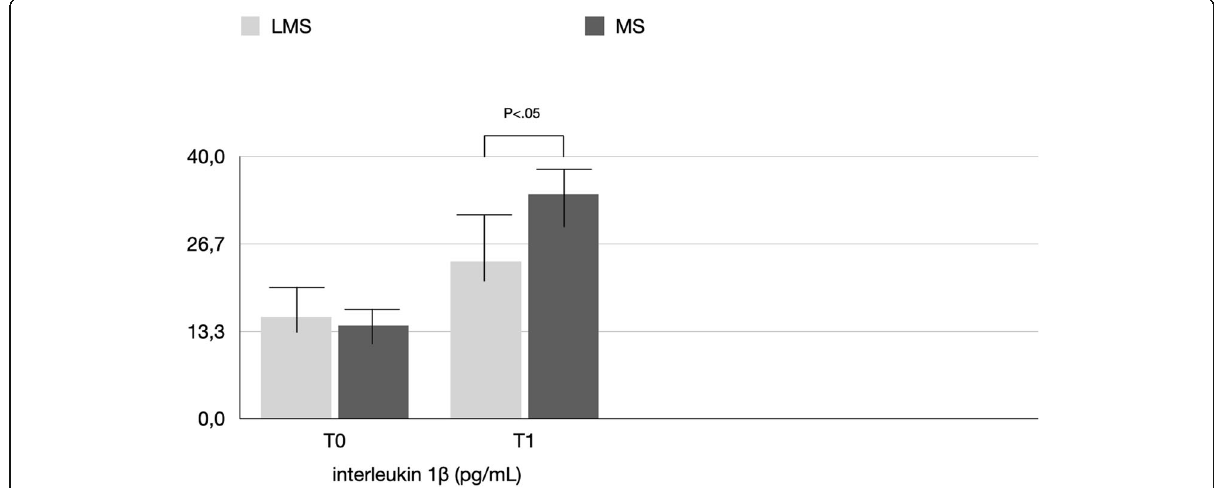
Fig. 5 Mean levels of interleukin 1 β (pg/mL) detected in the LMS and MS groups